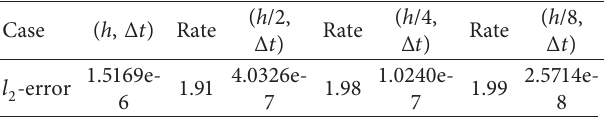
Table 6: Convergence test results of the fully implicit method for space step.